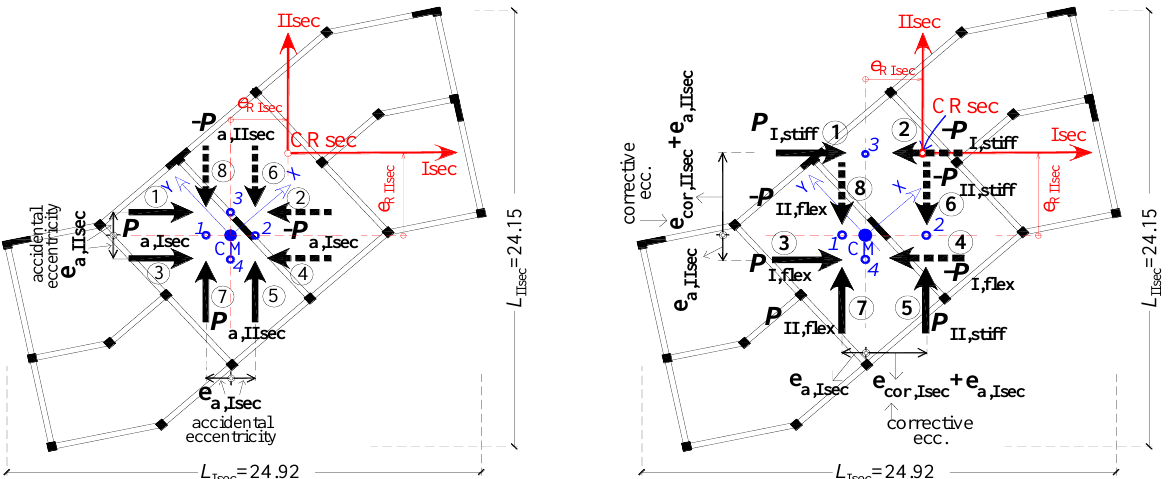
Fig. 10. Pushover methods: left: EN 1998-1 (N2), right: “corrective eccentricity method” by Bosco et al .